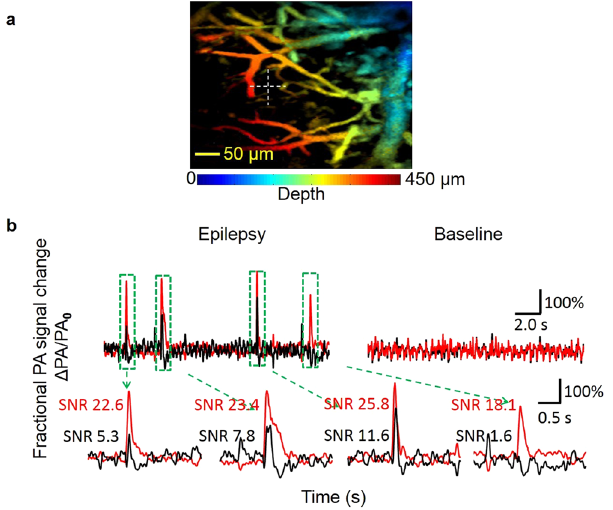
Figure 3. In vivo mouse brain response before and during 4-Aminopyridine (4-AP) induced epilepsy. ( a ) The white cross identifies the M-mode recording point on the depth-encoded maximum amplitude projection image of the mouse brain through the cranial window. The color represents depth. ( b ) Fractional voltage and fractional hemodynamic signal changes in the time domain for the baseline (before 4-AP stimulation) and response (during 4-AP induced epilepsy). The SNRs of the voltage and hemodynamic response peaks are labeled with red and black text. The fractional voltage response signal change shows stronger responses (spike amplitudes) than the fractional hemodynamic signal